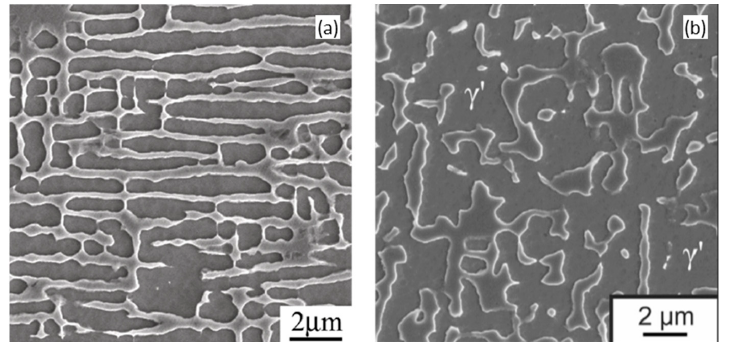
Figure 2. The formation of ( a ) spontaneous rafts in DD11 alloy after thermal exposure of 1070 °C/300 h [27] and ( b ) topological phase inversion in interdendritic areas in ERBO/1 alloy after thermal ex- posure of 1100 °C/250 h [36].